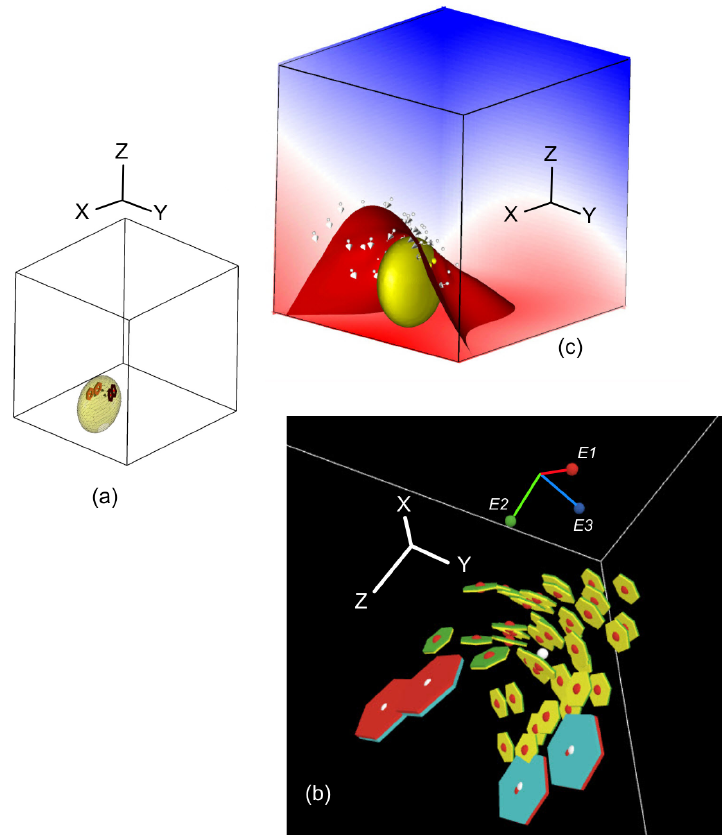
Figure 8. Surface model (closed yellow ellipsoid) utilizing implicit calculations with SURFE (Hillier et al., 2014) obtained by using only four on-contact dip data points (a) and then using the GeoSwarm program to extend a fold plunge, with 50 off-contact spatial structural agents depicted from the bottom (looking up) in panel (b) . The red surface in panel (c) is a more spatially continuous antiformal structure, obtained using the structural agent approach, than the structure obtained using implicit codes alone. Note that eigenvector E1 (red stick and ball) is pointing down the plunge of the fold, which is the strongest continuity